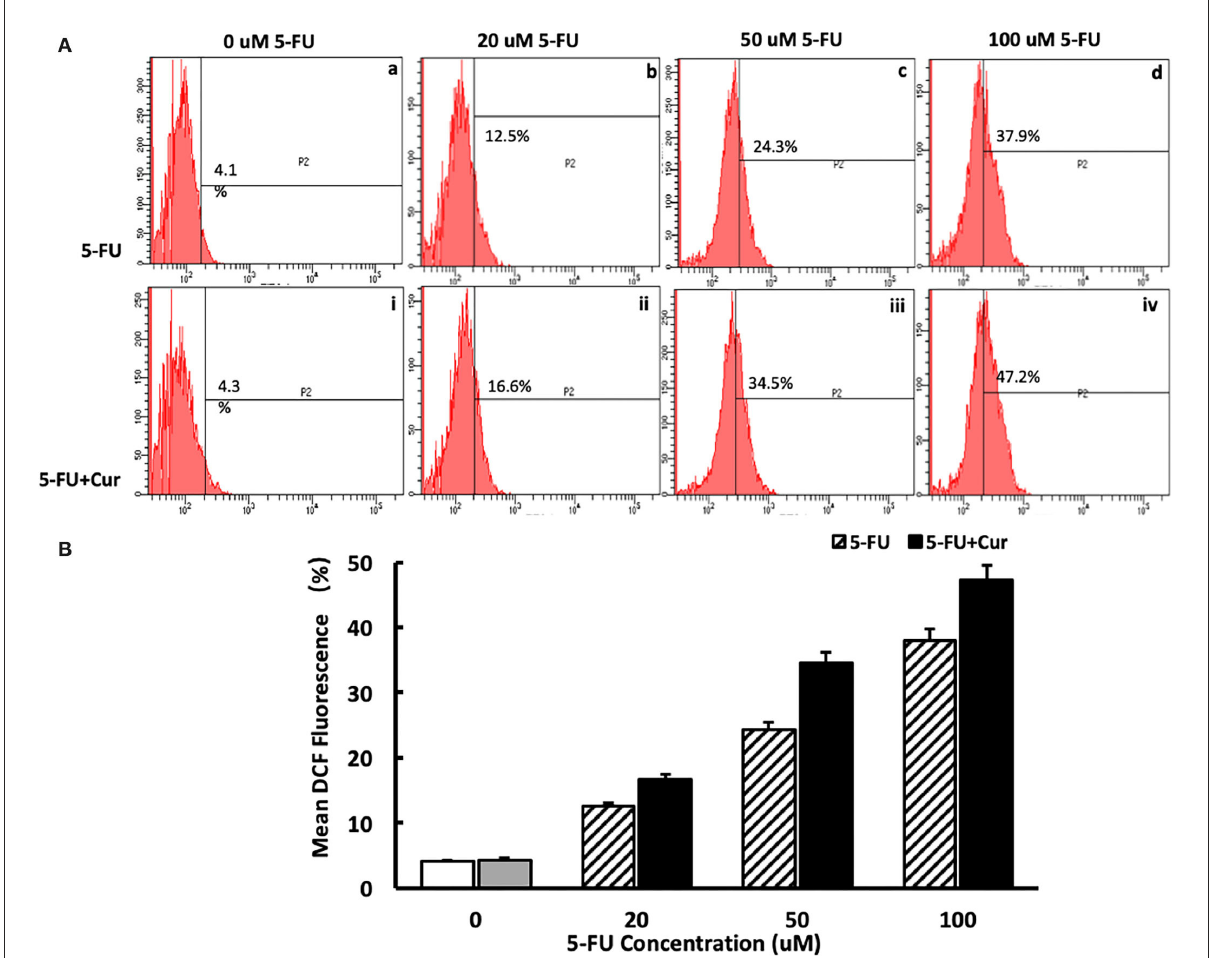
FIGURE5 Curcumin can increase the ROS level in SW480 cells treated with 5-FU. [ (A) : a–d] ROS level in SW480 cells treated with 5-FU (0, 20, 50, and 100) alone was slightly higher than that of the cells untreated, in a dose-dependent way. [ (A) : i–iv, (B) ] ROS level in SW480 cells treated with 5-FU (0, 20, 50, and 100 µ M) and curcumin increased significantly compared to those in the cells treated with 5-FU alone in a dose-dependent manner.